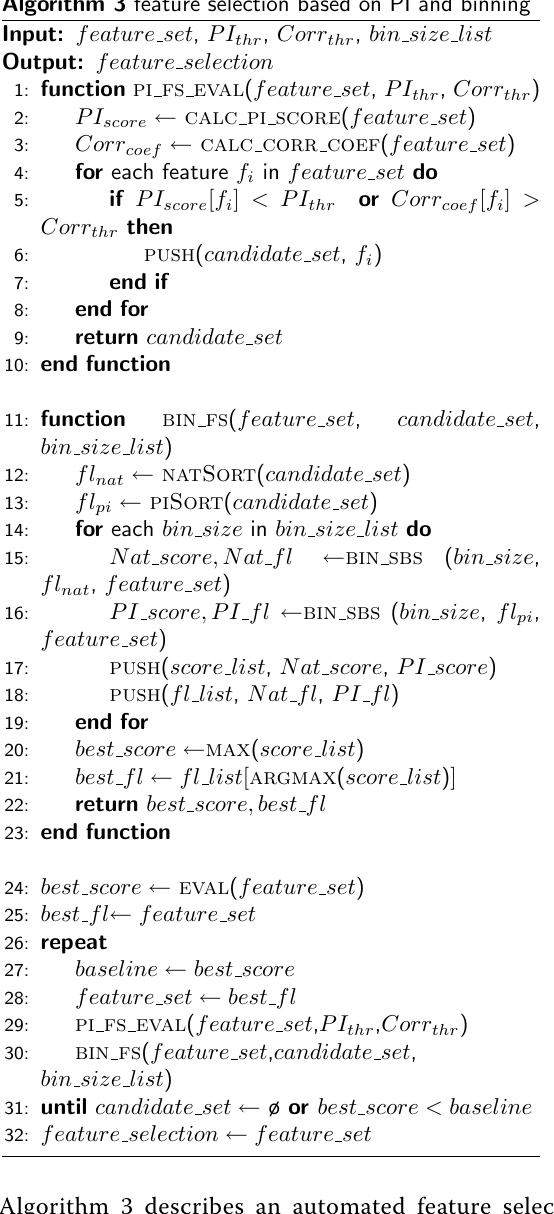
Algorithm 3 feature selection based on PI and